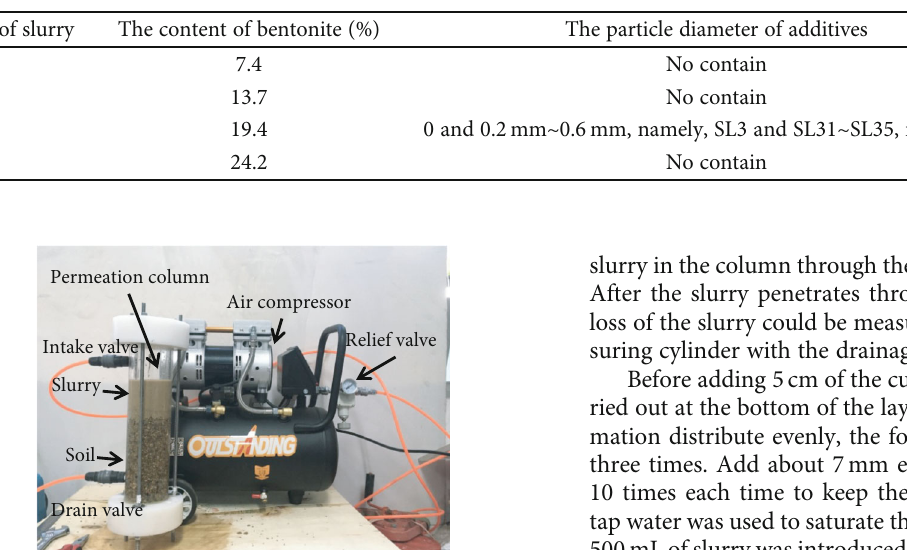
Table 2: Mass of each constituent in slurry.